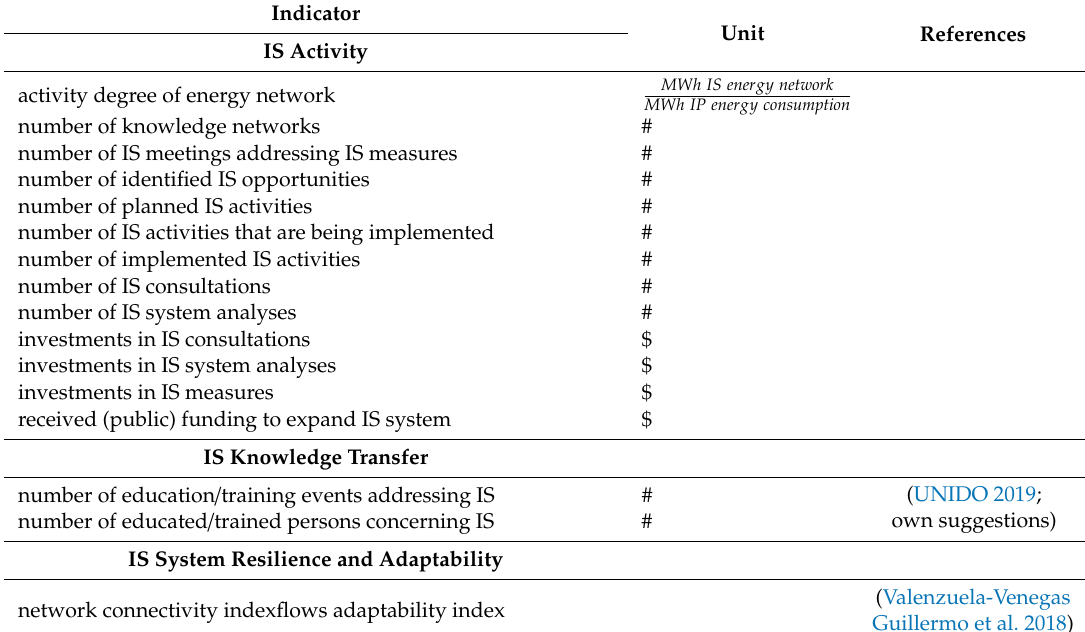
Table 3. IS general indicator system.